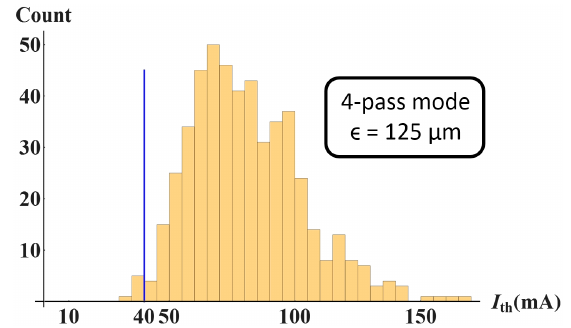
FIG. 4. 500 BBU simulation results of I 4-pass lattice. Each cavity is assigned with a random set of 10 dipole HOMs ( ϵ ¼ 125 μ